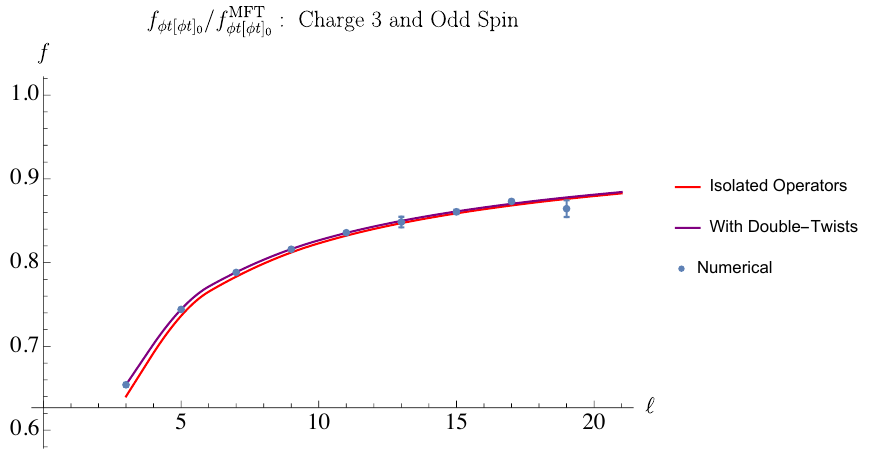
Figure 28 . The e(cid:11)ects of DTIs for OPEs of leading double twists in the charge 3 [ (cid:30)t ] 3 sector.